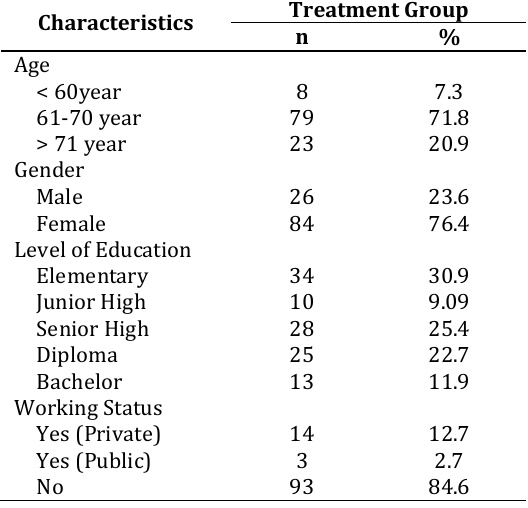
Table 1. Characteristics of the Respondents